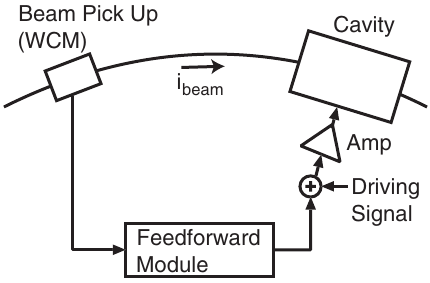
FIG. 5. A conceptual diagram of the rf feedforward method. The feedforward module generates (cid:2) i voltages are